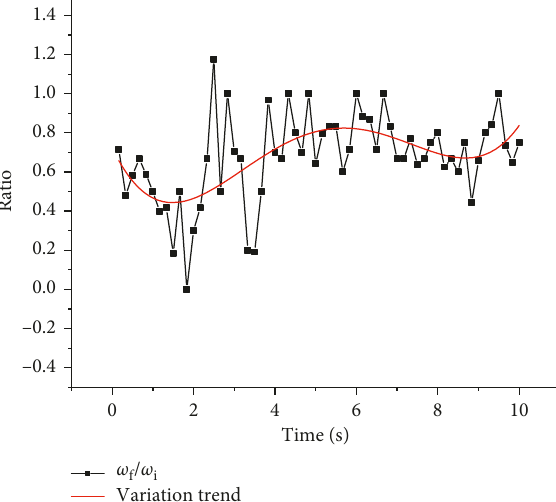
Figure 18: Specific angular speed value between the sleeve (with 4 rollers) and the shaft ( ω f / ω i